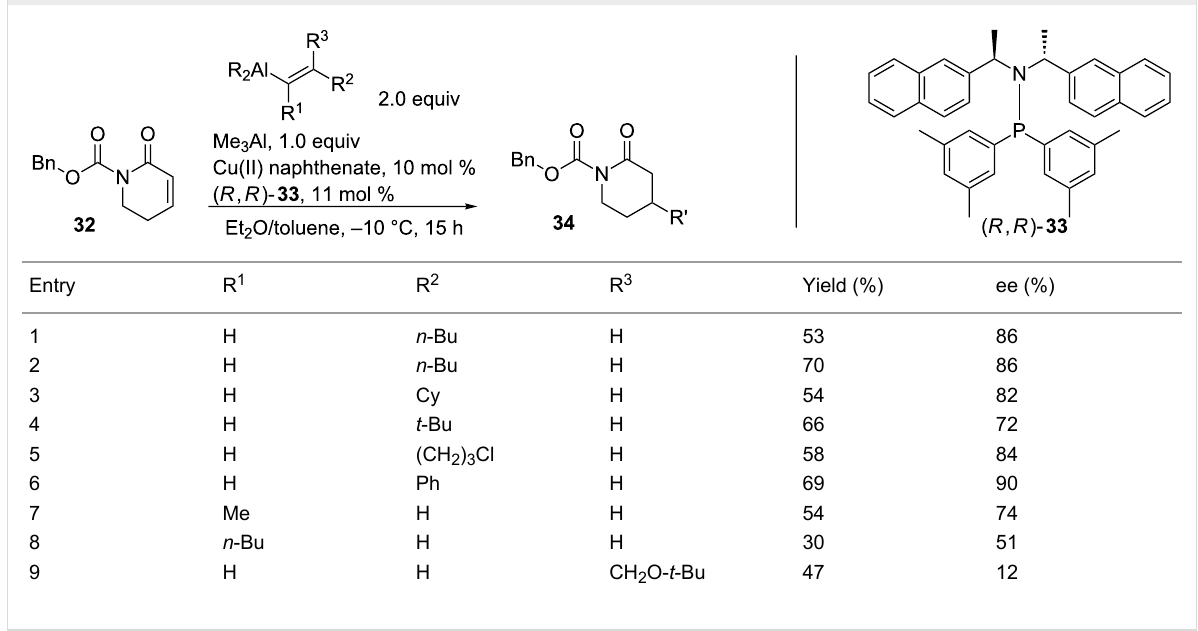
Table 2: Copper-catalyzed ECA reactions of alkenyl nucleophiles to an α , β - unsaturated